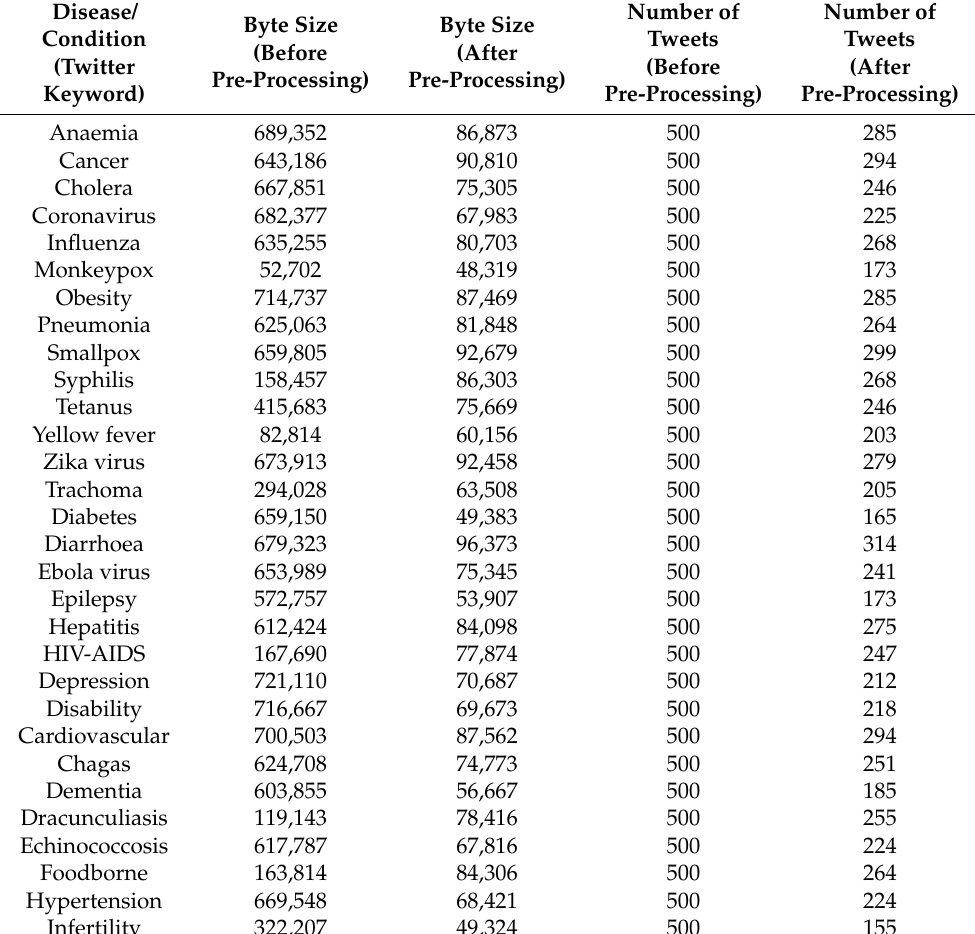
Table 4. Pre-processing